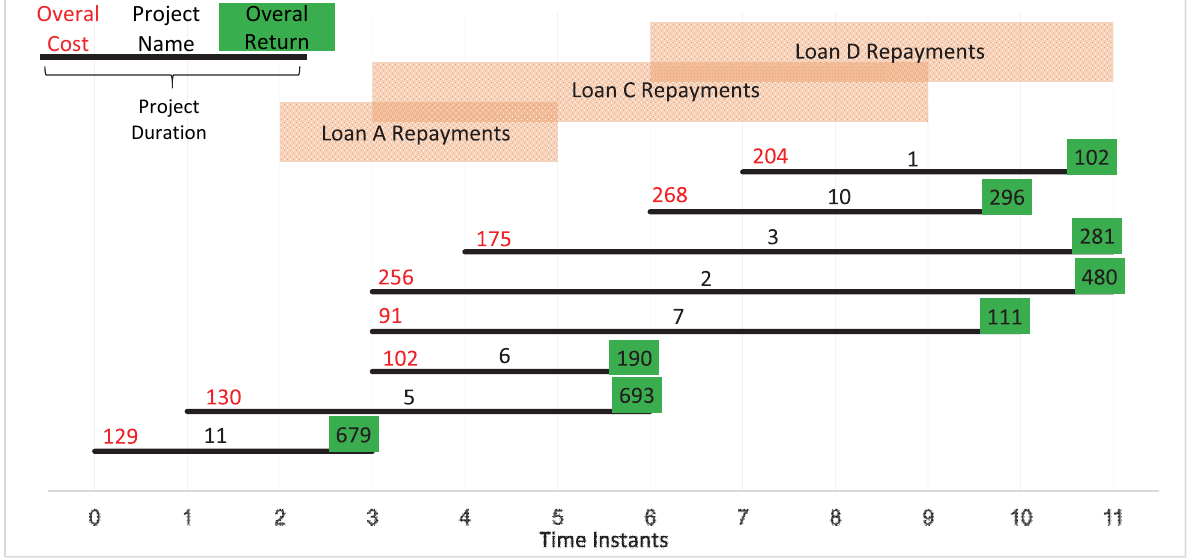
Fig. 1. Portfolio scheduling